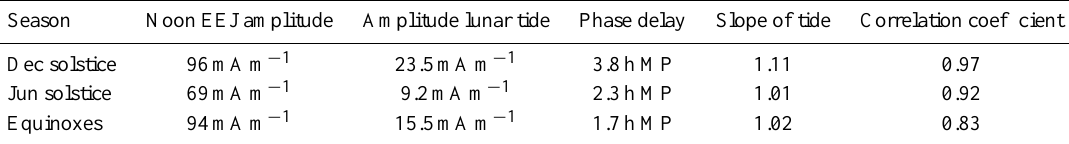
Table 1. Characteristic features of the EEJ lunar tides separately for the three Lloyd’s seasons. The phase propagation of the tidal wave has been determined by linear regression.